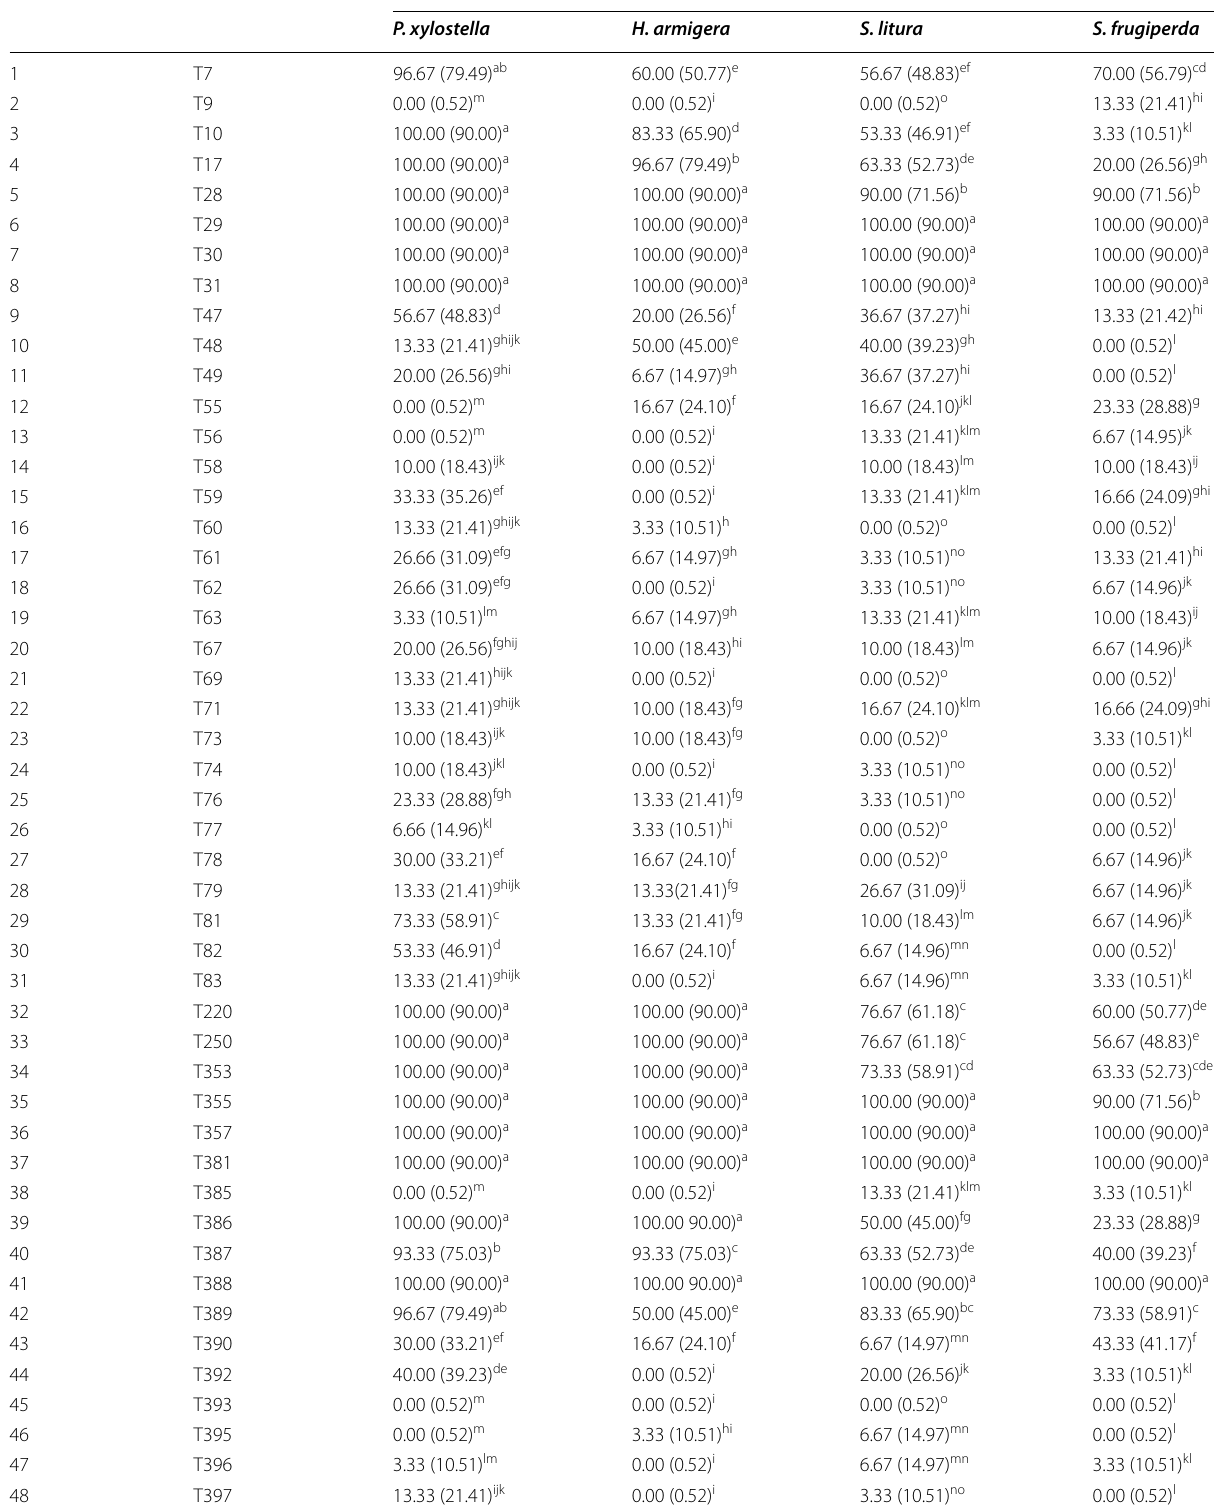
Table 5 Toxicity of indigenous Bt isolates against Lepidopteran pests Sl. No Bt isolates Larval mortality (%) 72 h after treatment (20